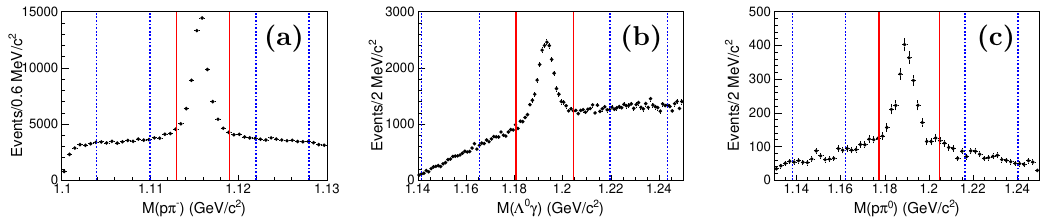
Figure 1 . The invariant mass distributions for Λ , Σ 0 , and Σ + candidates from data samples. The red solid lines show the required signal regions, and the blue dashed lines show the defined mass sidebands.